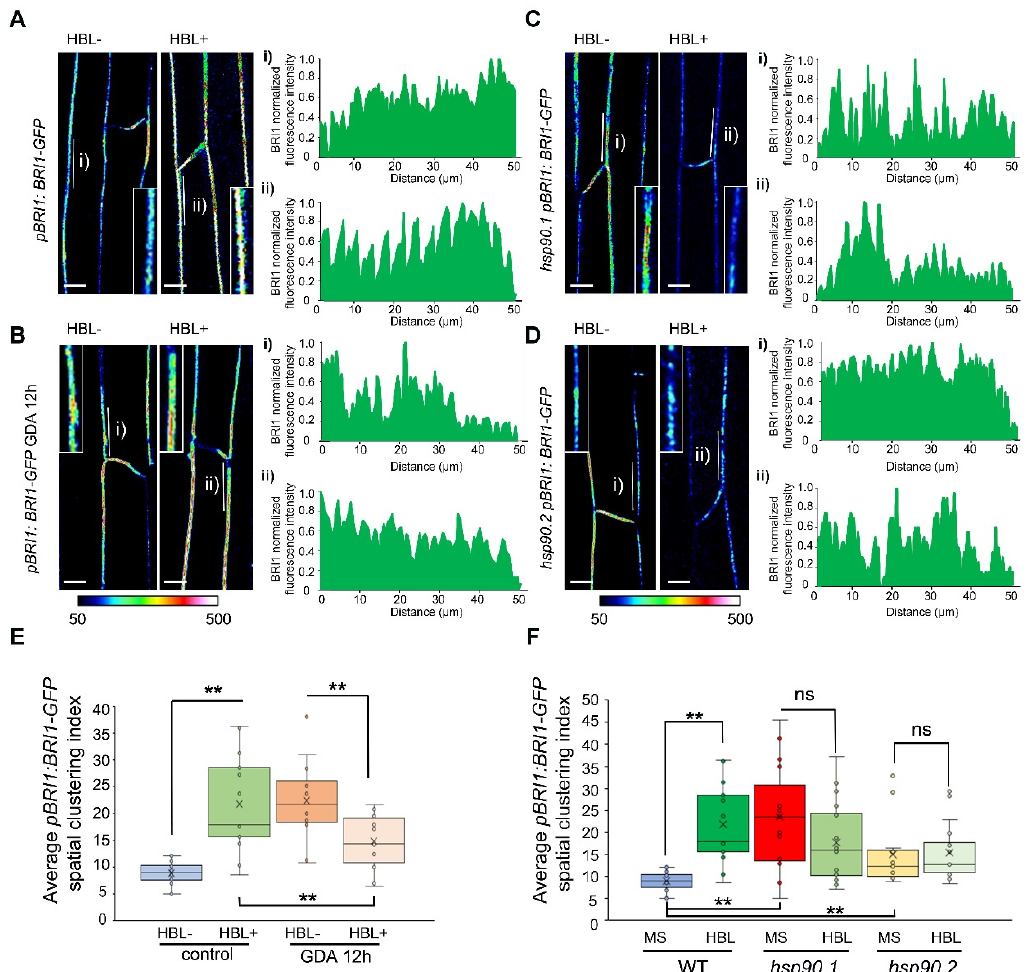
Figure 5. HSP90 function controls the spatial dynamics of BRI1 receptor at the plasma membrane modulating BR response. ( A – D ) LUT images representing a quantitative fluorescence intensity evaluation of BRI1-GFP expression levels in the indicated treatments and genotypes using a pseudo- color-coded range from the scale, where dark blue represents zero intensity (50 in arbitrary units) and white represents maximum intensity (500 in arbitrary units). The white lines mark the PM region used for the quantification of the fluorescence signal intensity to generate the BRI1 clustering index presented in plot profiles at the right of the images. Insets show magnifications of the region of PM used for quantification. Plot profiles ( i ) and ( ii ) correspond to cells residing in the areas marked with white lines. Propidium iodide (PI) cell wall stain was used to visualize the cell patterns in etiolated hypocotyls. Scale bar: 10 μ m. ( E ) Quantification of the average spatial clustering index of BRI1 at the PM of etiolated hypocotyl cells of treated and untreated seedlings with 100 nM HBL for 4 h or after pretreatment with 10 μΜ GDA for 12 h. ( F ) Quantification of the average spatial clustering index of BRI1 at the PM of etiolated hypocotyl cells of treated and untreated seedlings with 100 nM HBL for 4 h of the indicated genotypes. In box plots, the middle line in the box represents median, the × shows mean, the bottom line depicts the 1st quartile, while the top line describes the 3rd quartile; the vertical lines (whiskers) extend to the minimum and maximum value within the 1.5× interquartile range (distance between the 1st and the 3rd quartile); points outside of the whiskers mark outliers (values outside of the 1.5× interquartile range). The data were analyzed with one-way ANOVA followed by Tukey’s test, statistically significant differences compared to control are shown, ** is significant at p ˂ 0.01, ns—not significant. Asterisks indicate the significance be- tween the pair of treatments compared.